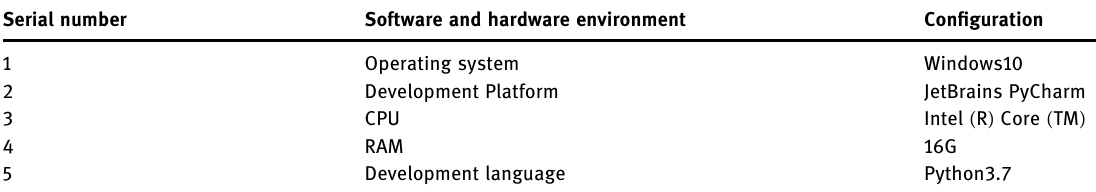
Table 1: Experimental con fi guration